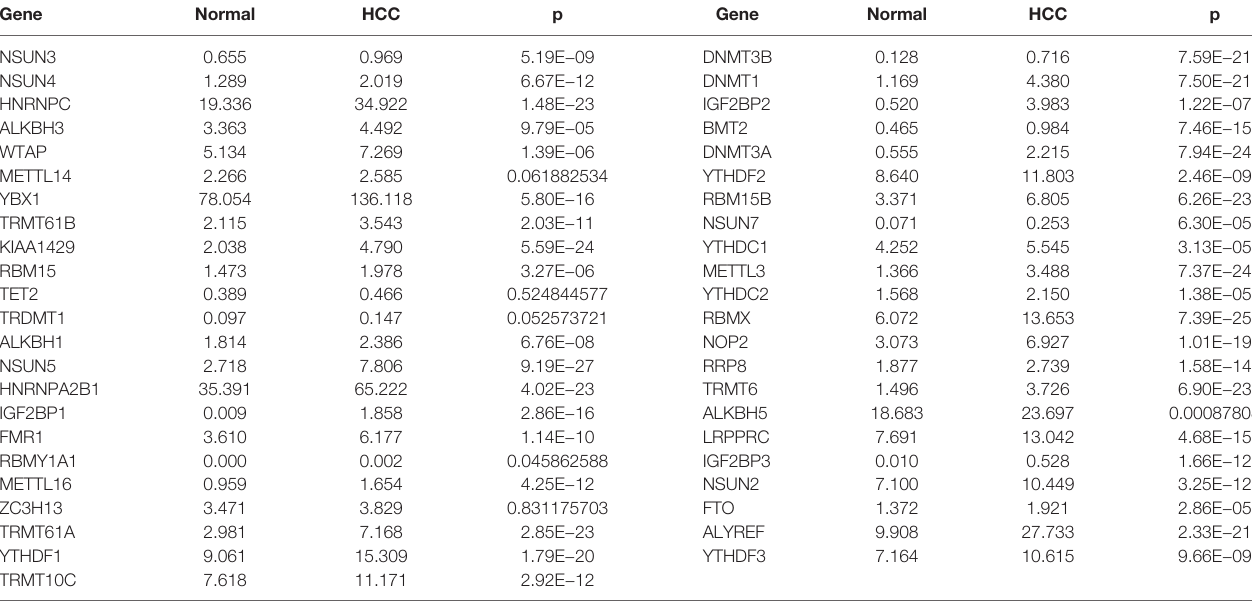
TABLE 2 | The expression levels of m6A/m1A/m5C regulated genes in HCC tissues. Gene Normal HCC p Gene Normal